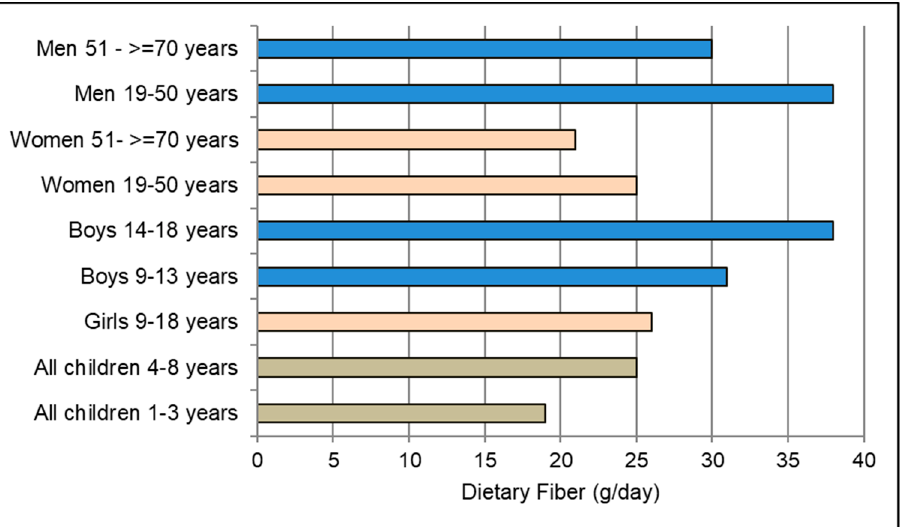
Figure 1. Recommended daily dietary fiber intake by age and gender [18].